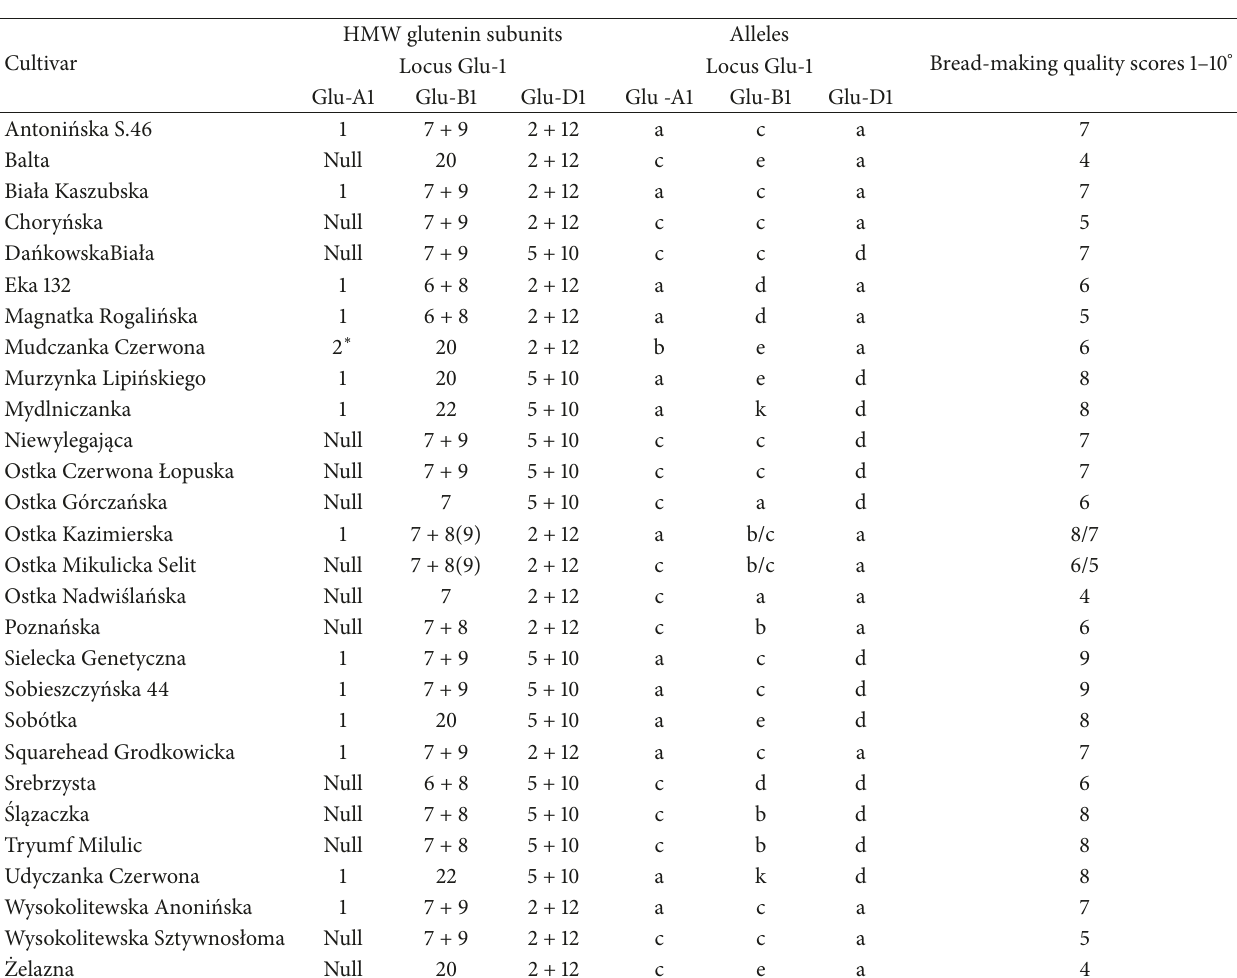
Table 2: Composition of the identified glutenin subunits of high molecular weight proteins in the studied wheat cultivars (SDS-PAGE).